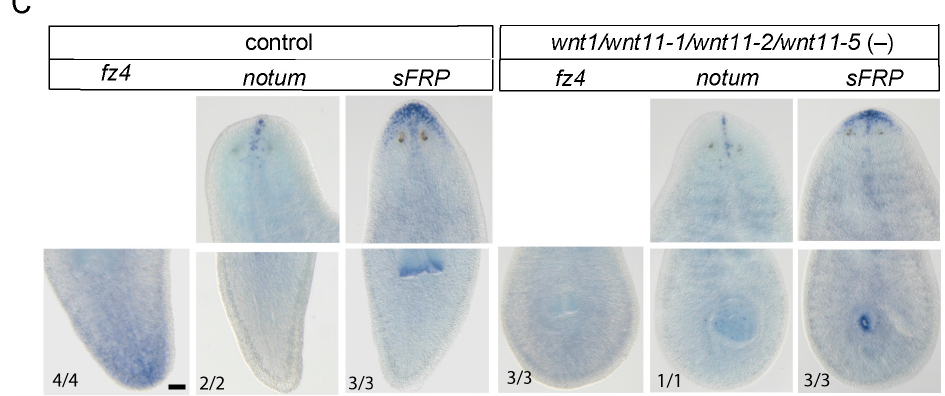
Figure 3. Silencing of all posterior wnts during homeostasis generates a strong “tailless” phenotype, without neither posterior nor anterior identity ( A ) After 6 rounds of Smed-wnt1 / Smed-wnt11-1 / Smed- wnt11-2 / Smed-wnt11-5 inhibition, planarians show a “tailless” phenotype in which the central region is also affected, since the pharynx cannot be maintained (yellow arrow points to a hole generated after the expulsion of the pharynx). (The number of animals analyzed for each condition was n = 7– 9); ( B ) TO-PRO-3 staining of the nucleus shows the “tailless” shape of RNAi planarians (yellow arrow) compared to controls (yellow asterisk), and the disorganization of the central region ( A ′ , two pharynges; B ′ , disorganized pharynx; C ′ , no pharynx, after expulsion). All images correspond to confocal z-projections; and ( C ) “Tailless” Smed-wnt1 / wnt11-1 / wnt11-2 / wnt11-5 RNAi animals do not show expression of either posterior ( Fz4 ) or anterior ( sFRP , notum ) markers in the posterior region. Anterior markers are normally expressed in the anterior region. Anterior is up, posterior is down in all images . Scale bar: 500 µm ( A ), 100 µm ( B , A ′ , B ′ and C ′ ) and 100 µm ( C ).